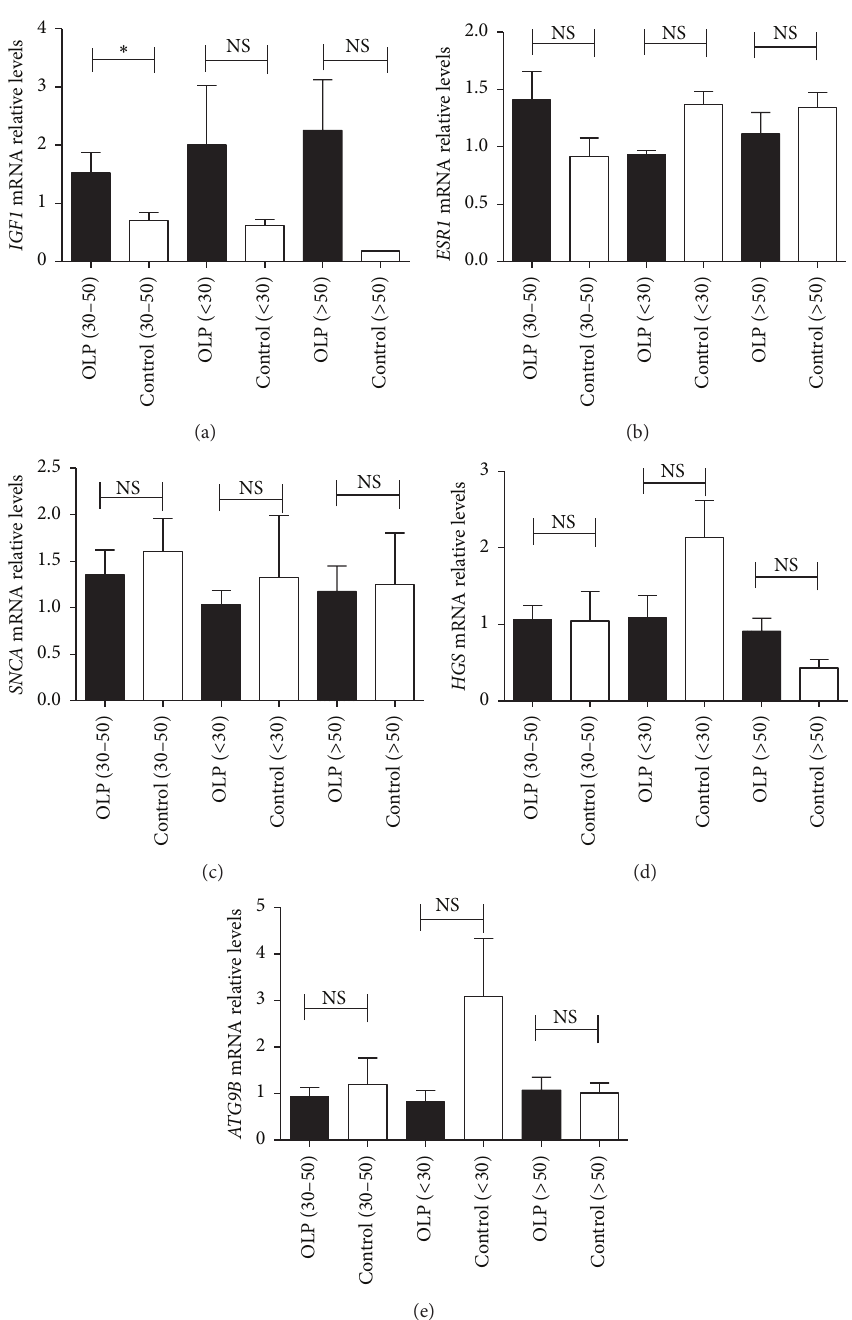
Figure 5: Expression of IGF1 , ATG9B , HGS , ESR1 , and SNCA mRNA in T cells from different age groups of OLP patients. The subjects were divided into three age groups, including those aged < 30 (OLP patients [ 𝑛 = 4 ] versus controls [ 𝑛 = 3 ]), those aged 30–50 years old (OLP patients [ 𝑛 = 13 ] versus controls [ 𝑛 = 4 ]), and those aged > 50 (OLP patients [ 𝑛 = 5 ] versus controls [ 𝑛 = 3 ]). Data were shown as mean ± SEM ( ∗ 𝑝 < 0.05 , NS: